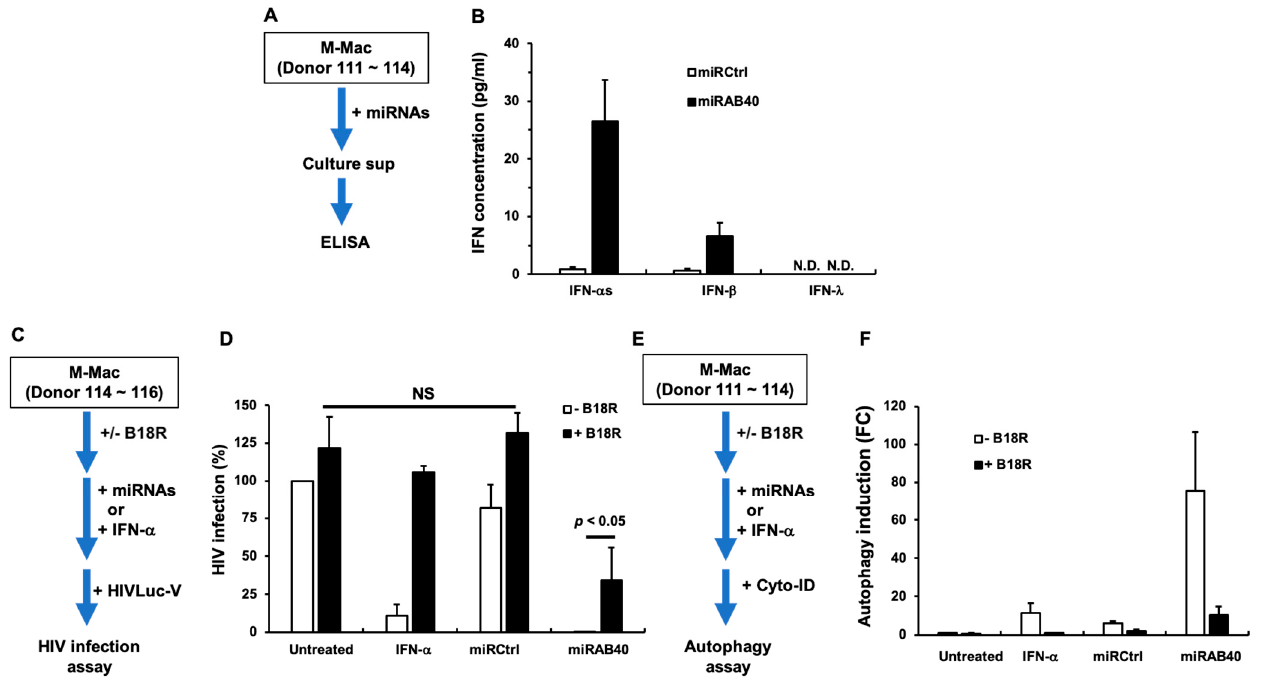
Figure 5. Evaluation of interferon (IFN)-inducing activity and correlation of IFN induction and anti-HIV and autophagy induction. ( A ) M-Macs from four independent donors (Donor 111~114) were transfected with miRCtrl or miRAB40 and cultured for 72 h. The culture supernatants were collected. ( B ) Each IFN concentration in the collected supernatants was measured using subtype-specific ELISA kit. Data represent mean ± SE. Detection limits of IFN- α s, - β and - λ s were 1.25, 1.2, and 15.6 pg/mL, respectively. ( C ) To determine a role of IFNs on HIV inhibition, M-Mac from three independent donor (Donor 114~116) were transfected with miRCtrl or miRAB40 in the presence or absence of 1 µ g/mL of B18R for three days and then infected with HIVLuc-V as described in the Materials and Methods. ( D ) HIV infection was quantified using with the Bright-Glo Luciferase kit. As a positive control for the neutralization of B18R effect, untransfected cells were treated with 100 units/mL of IFN- α 2b (R&D systems) for 3 days and then infected with the virus. Data indicate % of HIV infection compared with untreated cells from four independent assays using means ± SE. ( E ) To determine a role of IFNs on autophagy induction, M-Macs (Donor 111~114) were transfected miRCtrl or miRAB40 in the presence or absence of 1 µ g/mL of B18R for three days and then autophagy induction was detected using the Cyto-ID Autophagy detection kit as described in the Materials and Methods. ( F ) Autophagy inducing activities show fold change (FC) compared to that in untreated cells using means of FC ± SE from four independent assays. Each assay was conducted in quadruplicate. ND: not detected, NS: not significant.